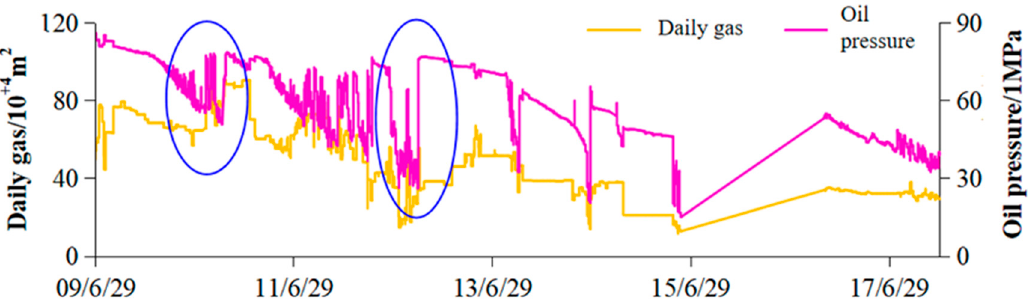
Figure 3. Relationship between gas production and oil pressure in a gas well at different times.